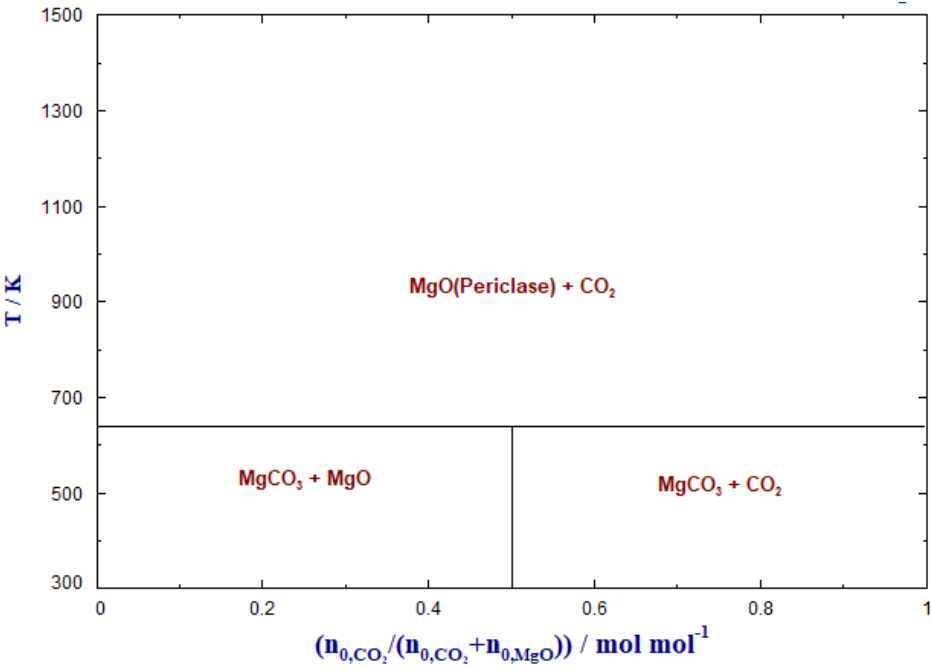
Figure 2. Equilibrium solid phase diagram of the system MgO–CO 2 : solid phase fields were pre- dicted as a function of the temperature and the feed hydrogen mole fraction; gaseous products are not shown; data calculated with FactSage 8.0™ (Thermfact and GTT-Technologies).